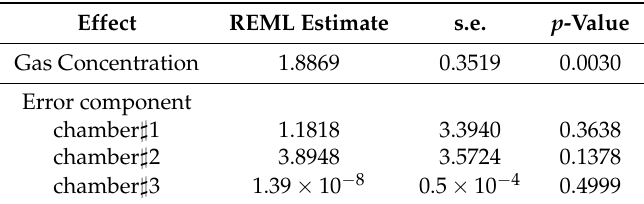
Table 7. REML estimates and variance components for the random part of Model (6) related to CO.